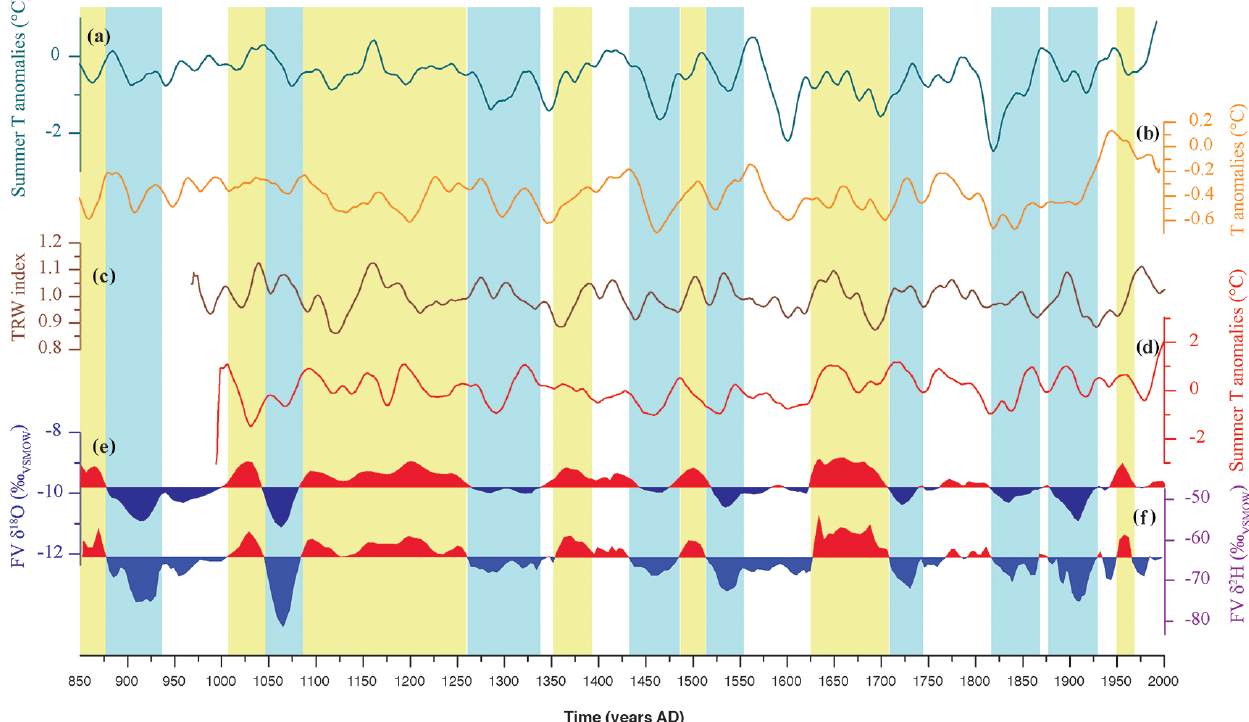
Figure 6. Summer climatic conditions recorded by δ 18 O and δ 2 H from the FV ice core (panels e and f , bottom) and comparison with proxy indicators from the Northern Hemisphere: (a) central European summer temperature anomalies (against the 1901–2000CE mean; Buntgen et al., 2011); (b) Northern Hemisphere air temperature anomalies (against the 1961–1990CE mean; D’Arrigo et al., 2006), (c) tree ring width index from Albania, southeastern Europe (Seim et al., 2012); (d) summer temperature anomalies in Romania (against the 1961–1990CE mean; Popa and Kern, 2009). Blue and yellow shaded areas indicate cold and warm periods, respectively.